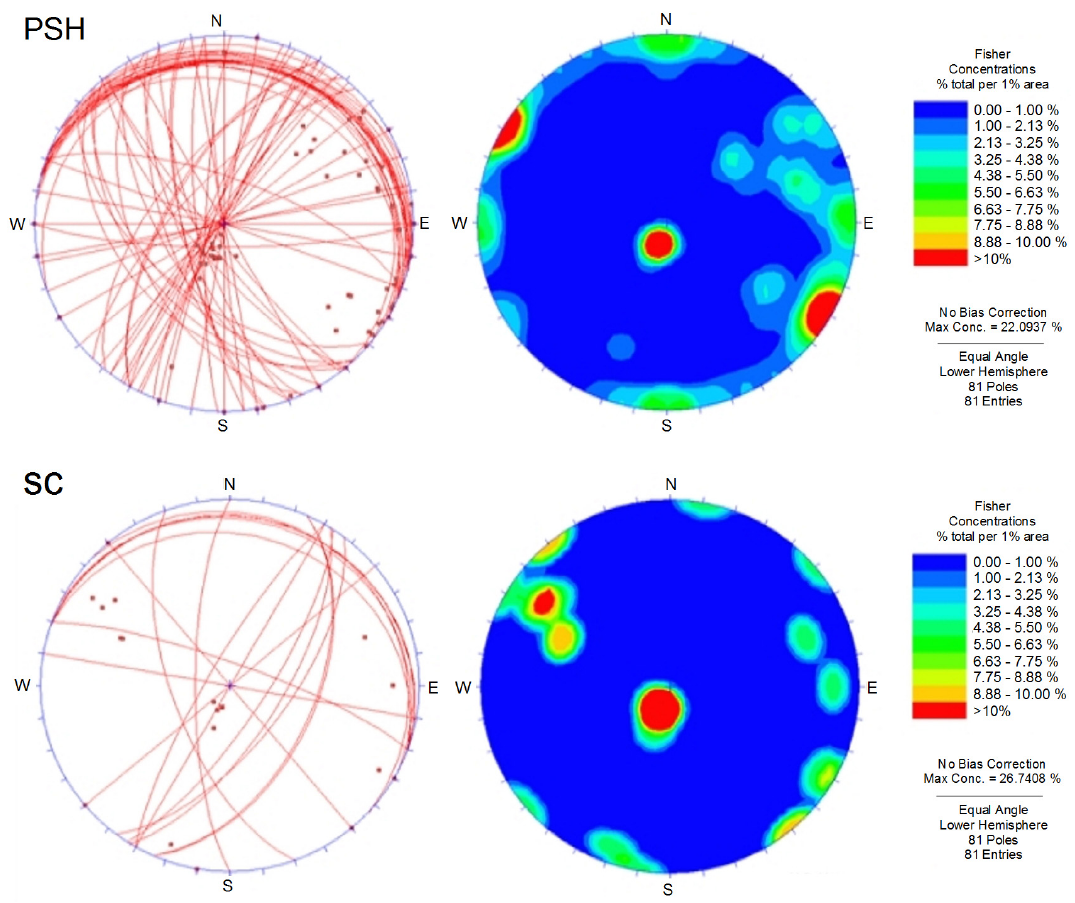
Fig. 7. Great circles and stereo plots for PSH Fm. and SC Fm. merged from the geomechanical measurements by direct and remote surveys.